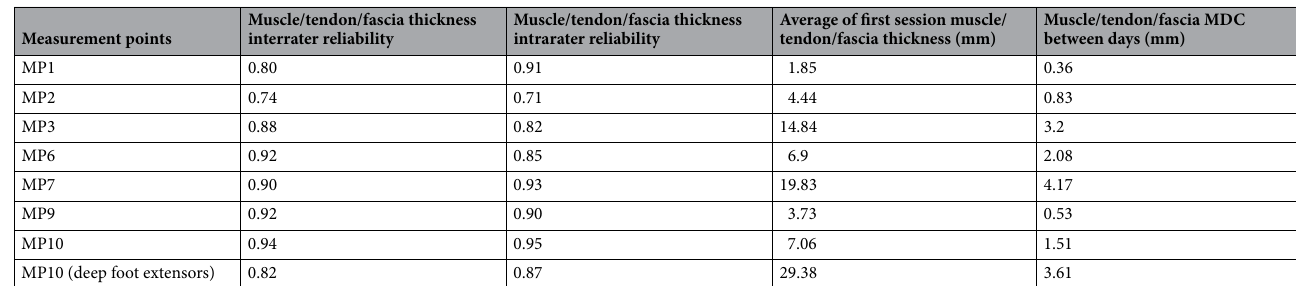
Table 5. Ultrasound imaging Muscle/tendon/fascia thickness results for interrater and intrarater (between- days) reliability, mean Muscle/tendon/fascia thickness, and minimal detectable change. MP1 Plantar Fascia, MP2 Achilles tendon, MP3 Soleus, MP6 Splenius capitis, MP7 Anterior Deltoid, MP9 Patellar tendon, MP10 Anterior